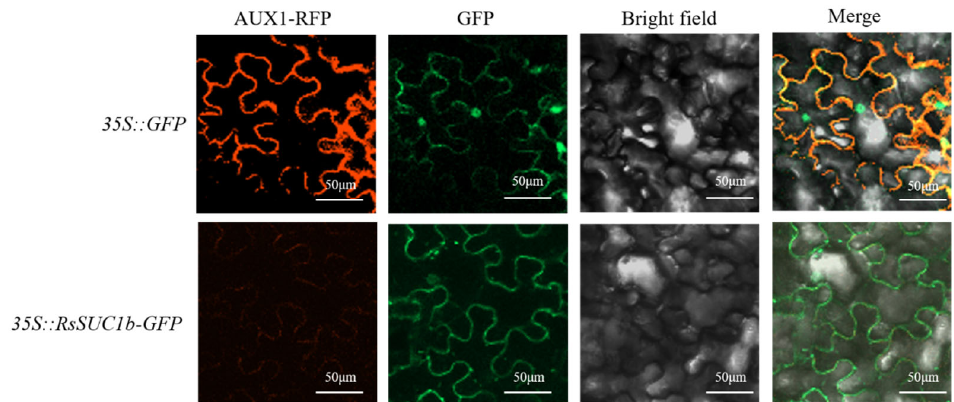
Figure 4. The subcellular localization of RsSUC1b in tobacco epidermal cells. The plasmids 35S::GFP and 35S::AUX1-RFP were used as the negative control and cell membrane marker, respectively. Scale bars = 50 μ m.